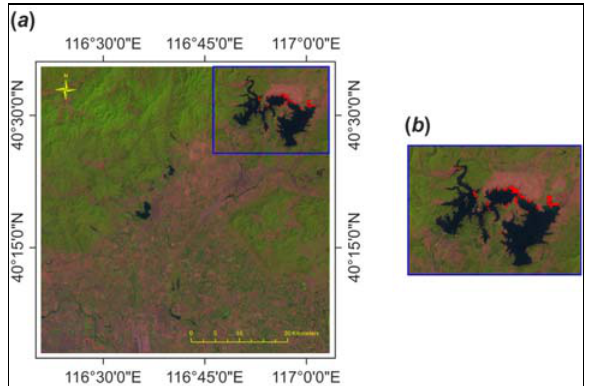
Table 6. Different land cover types contained in the land cover change